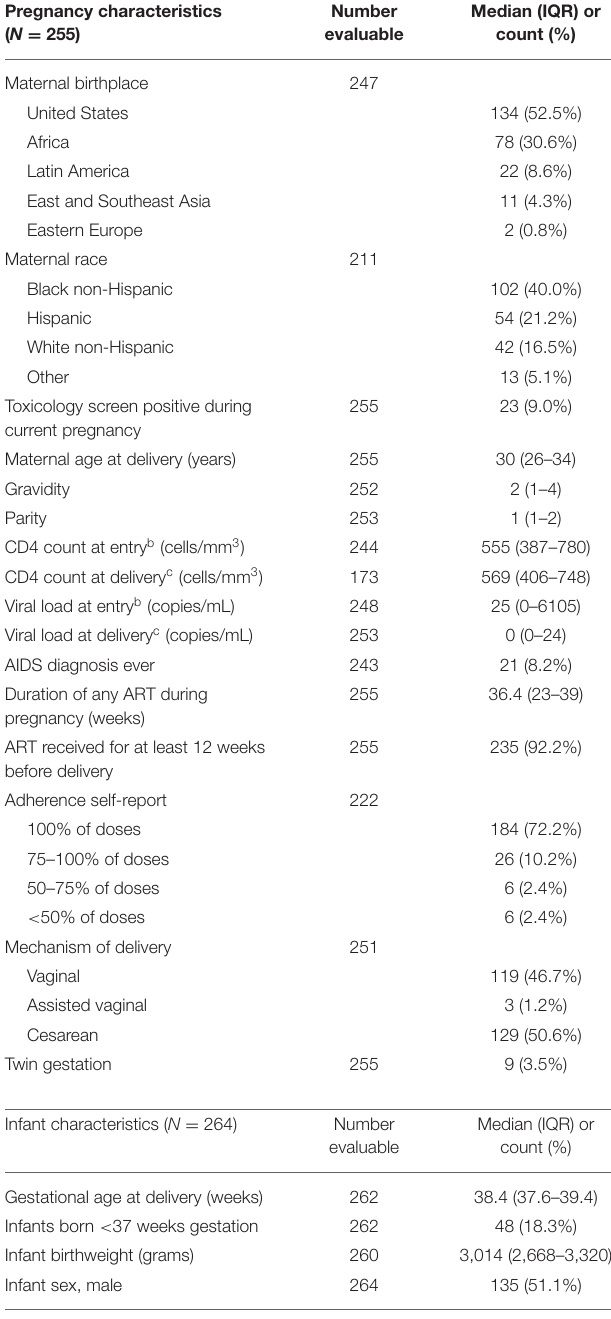
TABLE 1 | Demographics of mothers a and infants during the study